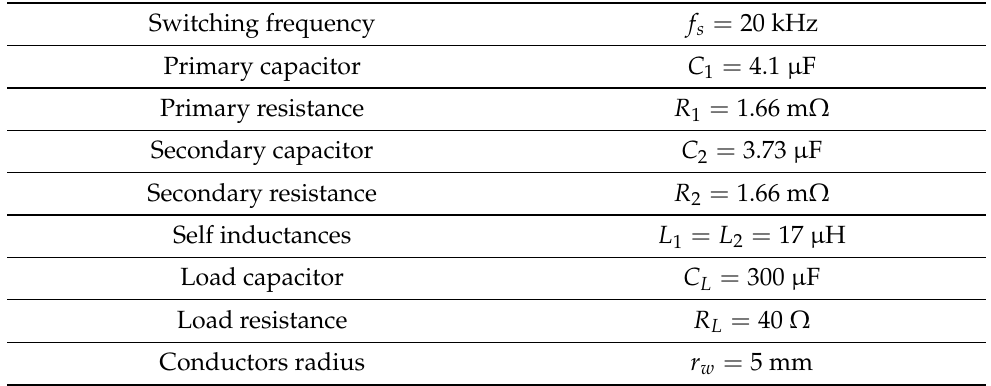
Table 1. Circuit parameters.